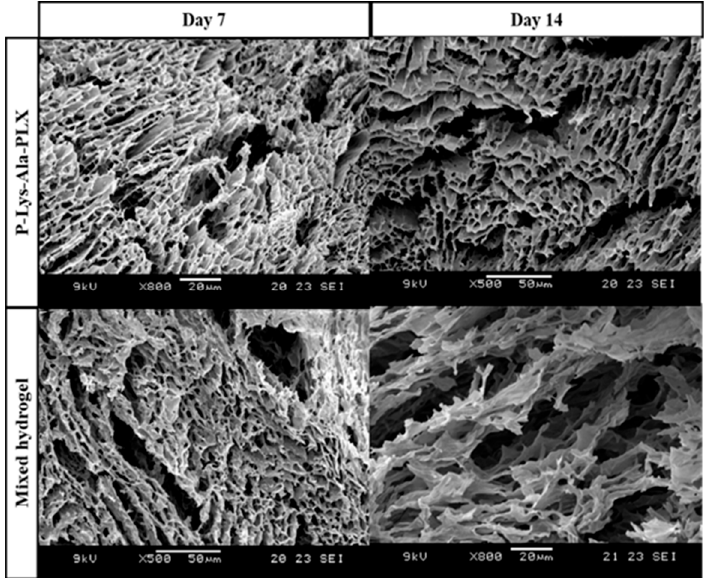
Figure 6. SEM microphotographs of P–Lys–Ala–PLX hydrogel and sample 5:1 mixed hydrogel after degradation in PBS with 5 U/mL elastase at 37 °C for 7 and 14 days.